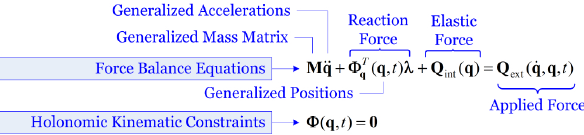
Figure 17. The equations of motion for Chrono